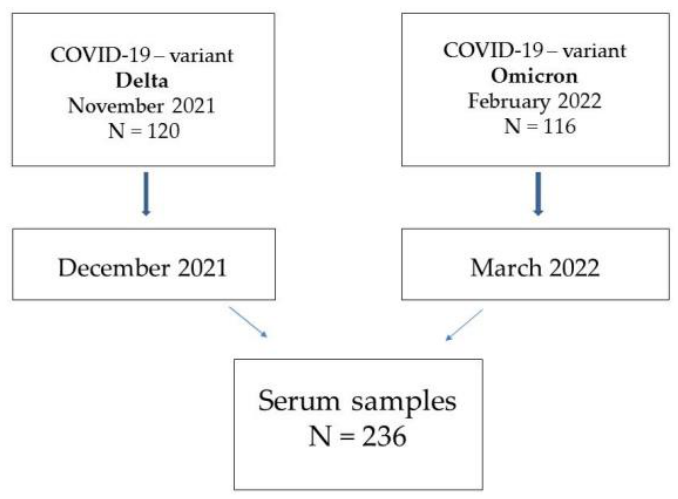
Figure 1. The scheme of study